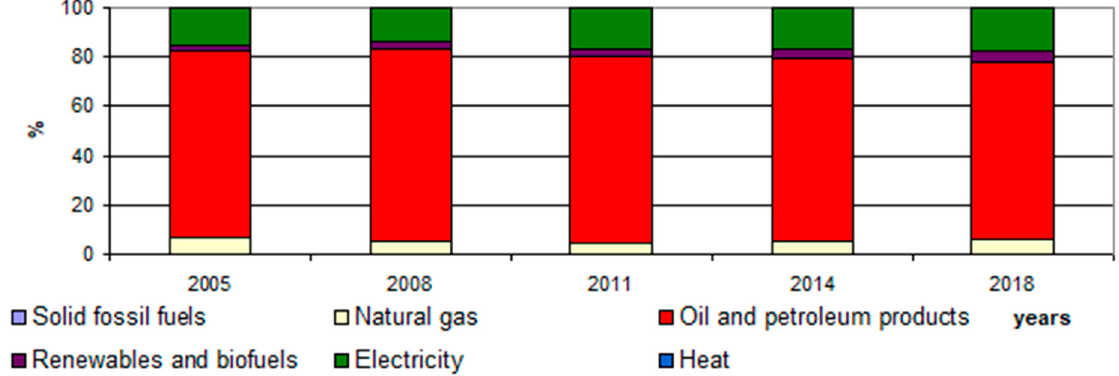
Figure 7. Structure of energy used in agriculture in France in 2005–2018.